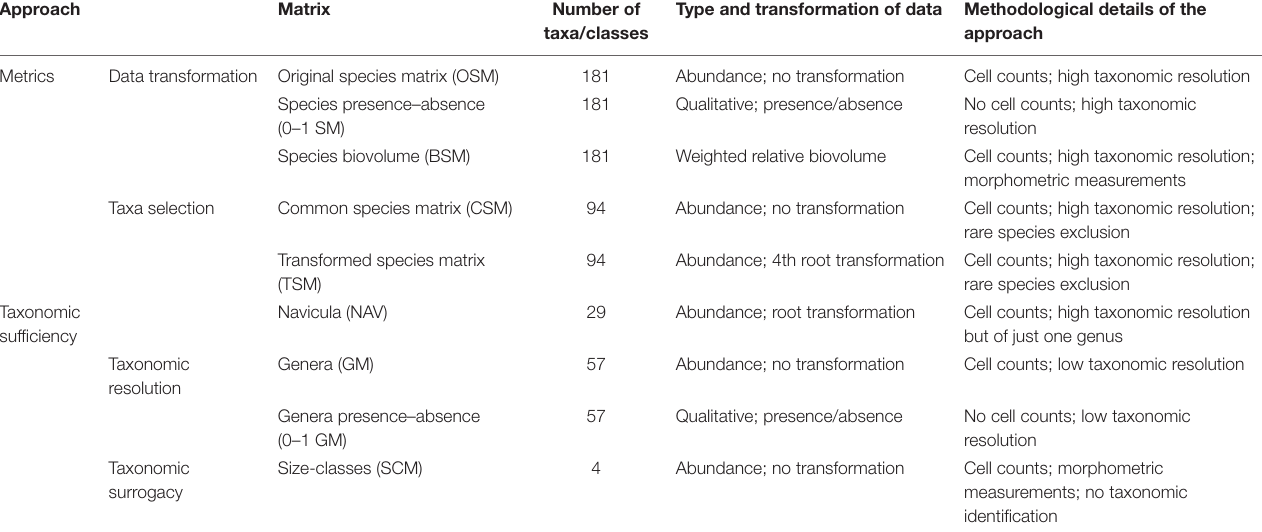
TABLE 1 | Different matrices used in this study, with number of taxa, type and data transformation, as well as the details on the methodological approach of each dataset. Approach Matrix Type and transformation of data Methodological details of the